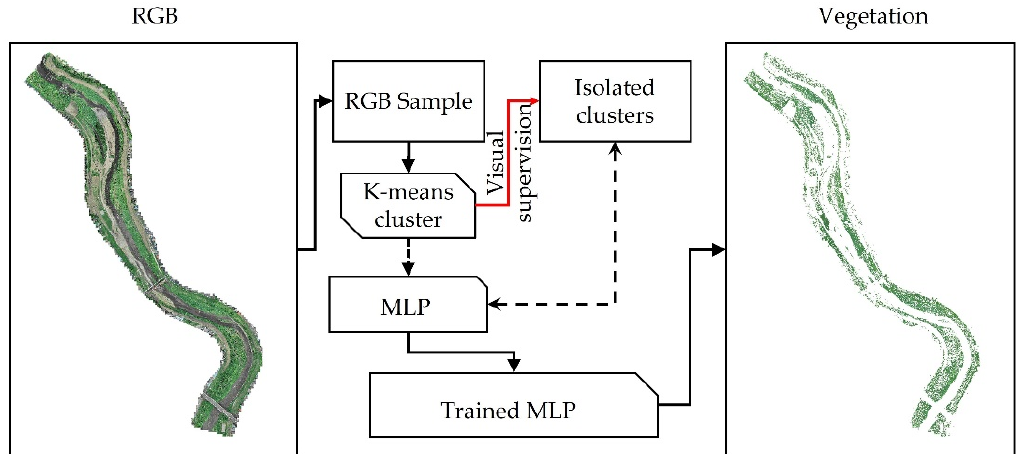
Figure 4. Flowchart of the method for the identification of the vegetated grid cells.